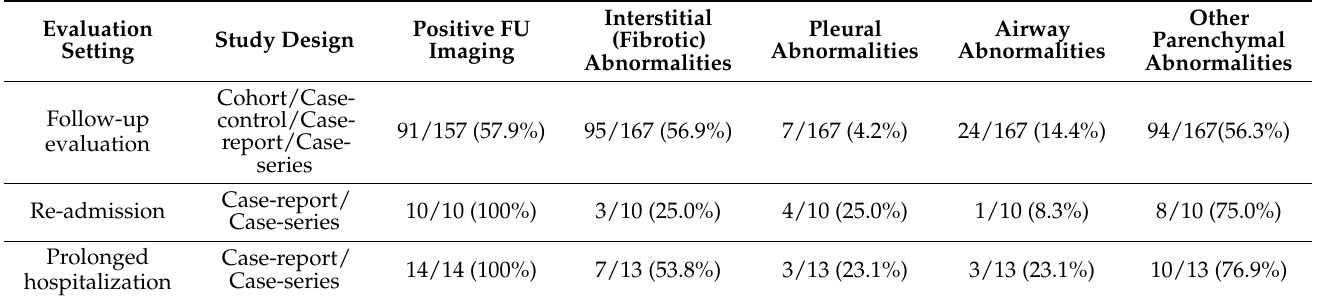
Table 4. Frequency of lung imaging abnormalities for each different evaluation setting.